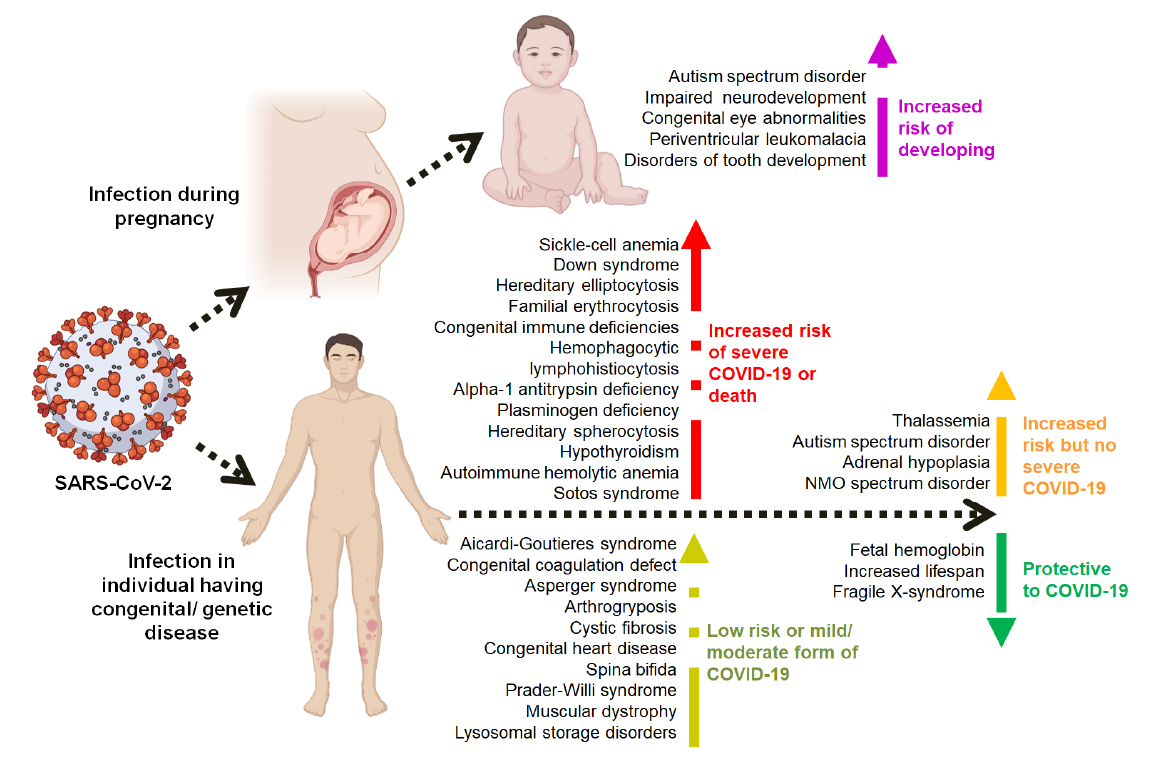
Figure 3. Summary of associations, disease–disease interactions, and impacts of COVID-19 in con- genital anomalies and genetic disorders. congenital anomalies and genetic